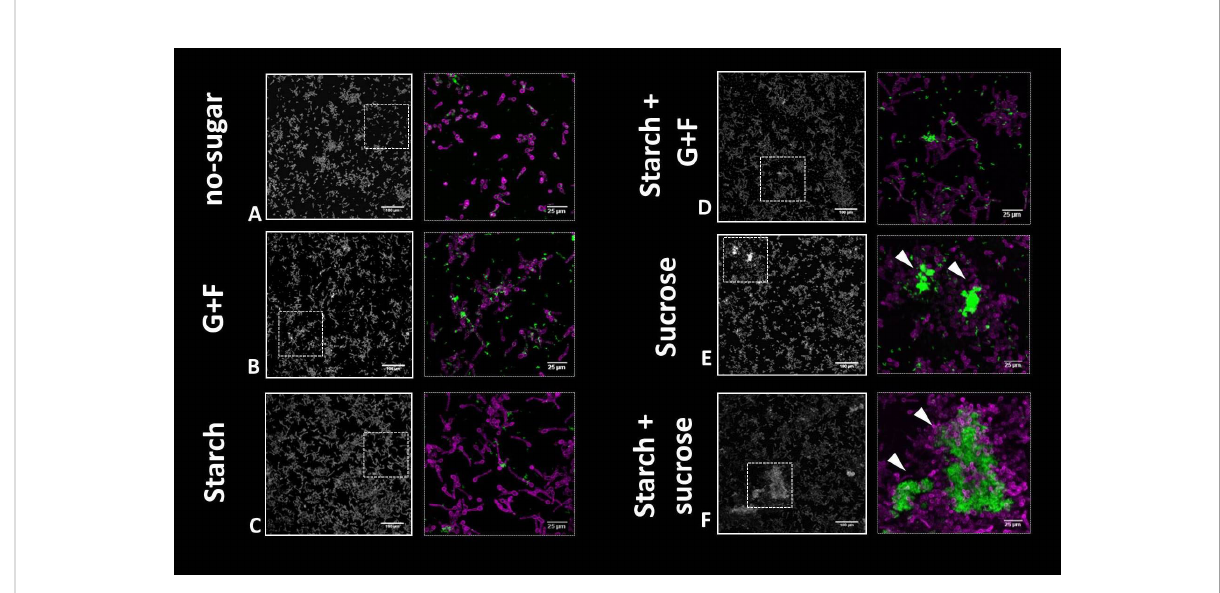
FIGURE 2 Binding of bacterial and fungal cells onto tooth-mimetic hydroxyapatite surface in saliva supplemented with different dietary sugars. (A-F) , representative images (z projection) showing surface-bound bacterial and fungal cells on the surface. The sugar condition is indicated to the left of the images. In each panel, the left image shows a large fi eld of view (640 m m × 640 m m; scale bar = 100 m m) and the right image shows a magni fi ed view (as shown using dotted box in the left image; scale bar = 25 µm). Green, S. mutans; purple, C. albicans . Arrowheads, sucrose or starch+sucrose-mediated inter-kingdom aggregates attached on the surface. G+F: